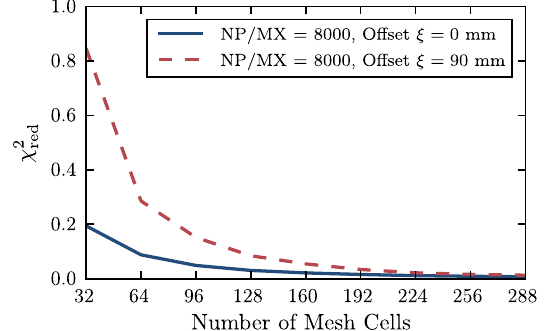
FIG. 6. χ 2 of the calculated ϕ compared to the simulated red values. It can be seen that the results are slightly worse for a beam close to the beam pipe. Also, for number of mesh cells in x-direction > 256 , only marginal improvement can be seen. These simulations were performed with a total number of particles NP ¼ 8000 · MX where MX denotes the number of mesh cells in x-direction (the independent variable in the